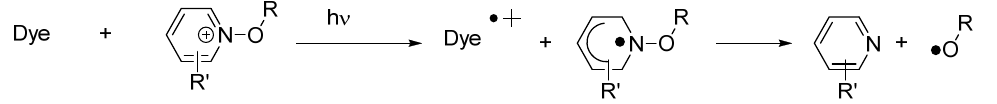
Figure 15. Chemical structures of 5,12-dihydroquinoxalino[2,3 b ]quinoxalines and alkoxypyridinium salts.